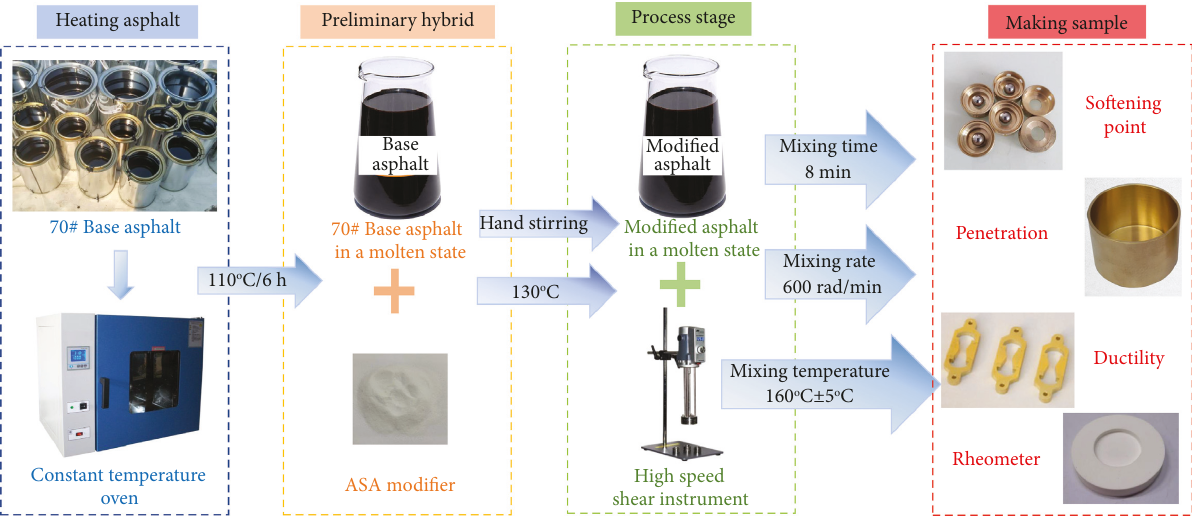
Figure 2: Preparation process of modified asphalt.